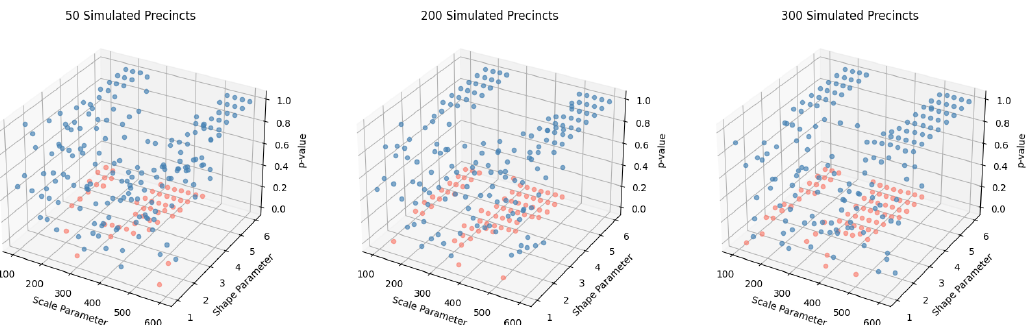
Figure 7. First Digit Base 3 Monte Carlo Analysis of Simulated Discrete Weibull Distributions with Various Choices of Parameterizations and Precinct Sizes Using Binomial Testing. p -values above 0.05 (plotted in blue) indicate conformance to 1-BL 3.